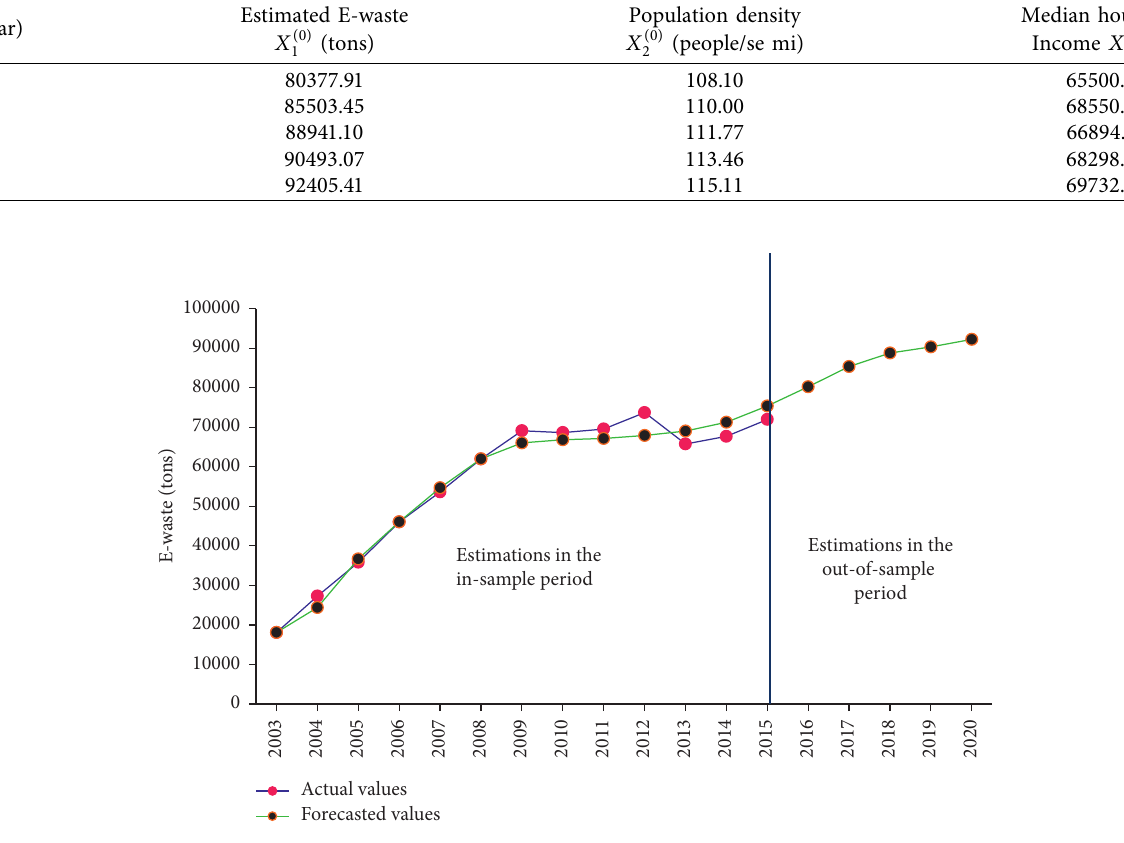
Figure 2: Visual comparison of the real observations and predicted values from 2003 to